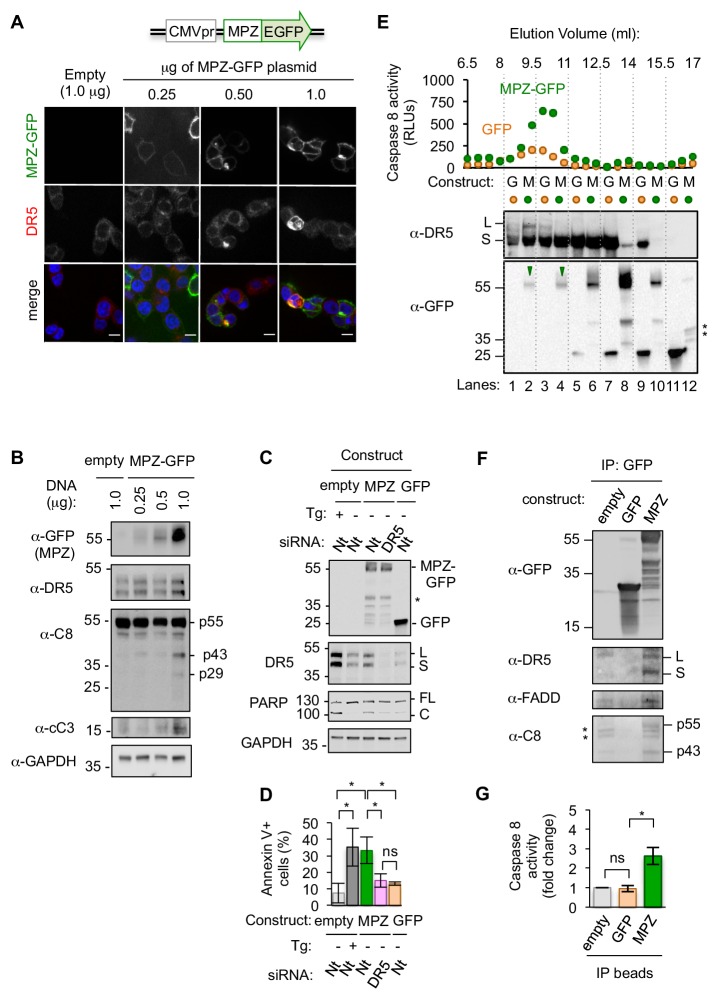
Misfolded proteins induce DR5-dependent apoptosis and assemble DR5-caspase 8 signaling complexes.(A) Confocal images of epithelial cells HCT116 fixed 24 hr post-transfection with 0.25–1.0 μg of a plasmid containing myelin protein zero (MPZ) tagged with a C-terminal monomeric EGFP or 1.0 μg of the empty vector showing MPZ-GFP fluorescence (green) and immunofluorescence with an antibody against DR5 (red) (scale bar = 5 μm). (B) Western blot of HCT116 cell lysates harvested 24 hr post-transfection with a titration of MPZ-GFP plasmid or the empty vector (C8 = caspase 8, cC3 = cleaved caspase 3). p55 represents full-length, inactive C8; p43 indicates a C8 intermediate after release of the active p10 subunit, and p29 corresponds to the released p18 and p10 subunits. (C) Western blot of HCT116 cells transfected with siRNA against a non-targeting (Nt) control or DR5 (48 hr) followed by the empty vector -/+ 100 nM thapsigargin (Tg), 1.0 μg MPZ-GFP, or cytosolic GFP (24 hr; * denotes degradation products; L and S denote the long and short isoforms of DR5, respectively; FL and C denote full-length and cleaved PARP, respectively). (D) Average percent of annexin V staining for HCT116 cells transfected as described in C) from n = 3 biological replicates (error bars = SEM; * indicates p<0.05; ns indicates p=0.46 as analyzed by unpaired t-test with equal SD). See Figure 1—figure supplement 4D for gating. (E) Top: Caspase 8 activity in size exclusion chromatography fractions from lysates of HCT116 cells transfected with MPZ-GFP or cytosolic GFP (24 hr). Bottom: Size exclusion fractions were pooled according to dotted grid lines and immunoblotted for DR5 and GFP (* denotes degradation products). (F) Immunoprecipitation of GFP-tagged proteins from lysates of HCT116 transfected with MPZ-GFP, cytosolic GFP, or the empty vector (L and S denote the long and short isoforms of DR5, respectively). The percent of total DR5 recovered has been quantified in Figure 1—figure supplement 5C. (G) Fold change in caspase 8 activity relative to the empty vector control for beads with immunoprecipitated contents shown in Figure 1F (error bars = SEM for n = 3 biological replicates; * indicates p=0.023 and ns indicates p=0.83 as calculated by unpaired t-tests with equal SD).Figure 1—source data 1.Caspase glo 8 measurements for IP of MPZ-GFP vs GFP.This zip archive contains the measured luminescent units for caspase glo 8 activity shown in Figure 1G (IP beads) and Figure 1—figure supplement 3C (input lysates). Coomassie gels used to normalize lysate concentration are included as. tif files.Figure 1—source data 2.Westerns and quantification of DR5 recovered on IPs.This zip archive contains images of the Western blots and measurements used to quantify the amount of DR5 in the IP samples relative to the input lysate.Figure 1—source data 3.FCS files and quantification of annexin V staining for MPZ-GFP.This zip archive contains FCS files from n = 3 biological replicates of HCT116 transfected with the conditions outlined in Figure 1D. The excel file contains the quantification of annexin V staining exported frow FlowJo.Figure 1—source data 4.qPCR analysis of MPZ-GFP titration.This zip archive contains the compiled excel file for qPCR data shown in Figure 1—figure supplement 1A along with the Prism 6 file used to perform multiple t-tests with Holm-Sidak correction for multiple comparisons.Figure 1—source data 5.Caspase glo 8 measurements for time course of MPZ-GFP transfection.This zip archive contains the measured luminescent units for caspase glo 8 activity shown in Figure 1—figure supplement 1E and the tif file of the Coomassie blue-stained gel used to normalize lysate concentrations.Figure 1—source data 6.qPCR and cell death measurement for CHOP expression.This zip archive contains the qPCR analysis from CHOP expression in Figure 1—figure supplement 2B, and brightfield images of Trypan Blue staining measured on the Countess II for n = 3 biological replicates, summarized in Figure 1—figure supplement 2D.Figure 1—source data 7.qPCR analysis of INS and RHO-GFP expression.This zip archive contains the compiled excel file for qPCR data shown in Figure 1—figure supplement 4A along with the Prism 6 file used to perform multiple t-tests with Holm-Sidak correction for multiple comparisons.Figure 1—source data 8.FCS files and quantification of annexin V staining for INS and RHO.This zip archive contains FCS files from n = 3 biological replicates of HCT116 transfected with the conditions outlined in Figure 1—figure supplement 4E. The excel file contains the quantification of annexin V staining exported frow FlowJo.Figure 1—source data 9.Caspase glo 8 measurements for IP of INS and RHO-GFP.This zip archive contains the measured luminescent units for caspase glo 8 activity shown in Figures 1S5B (input lysates and IP beads). Coomassie gels used to normalize lysate concentration are included as. tif files.